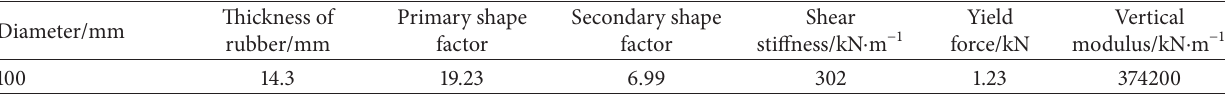
Table 7: Fundamental mechanical and material properties of base isolation devices.